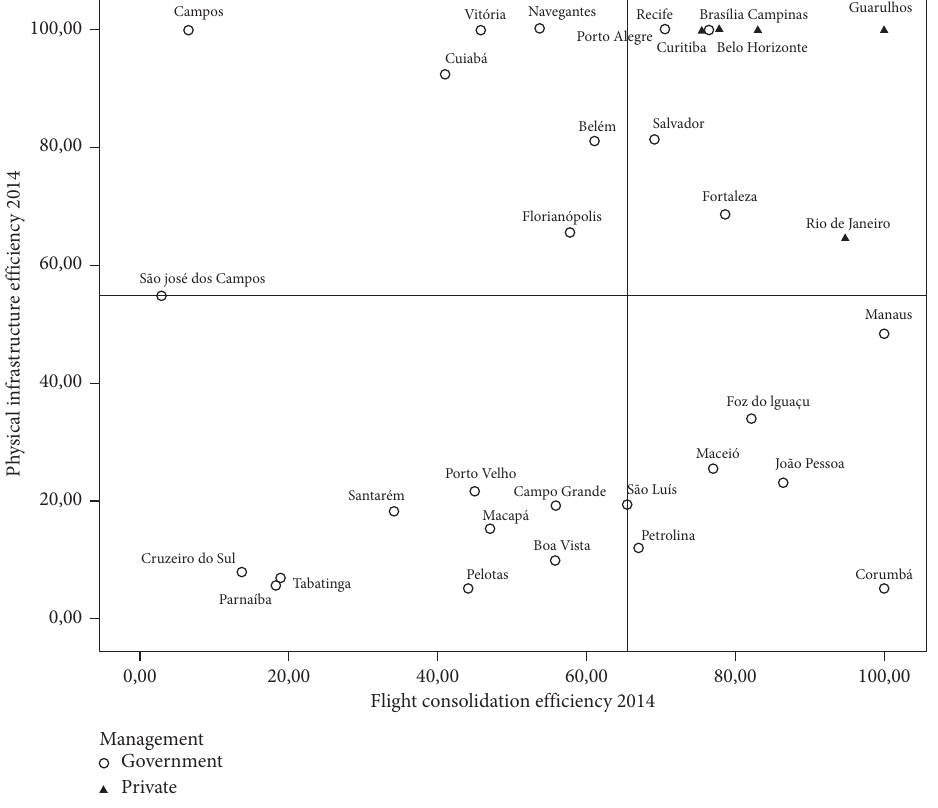
Figure 3: Comparison between the DEA stages,